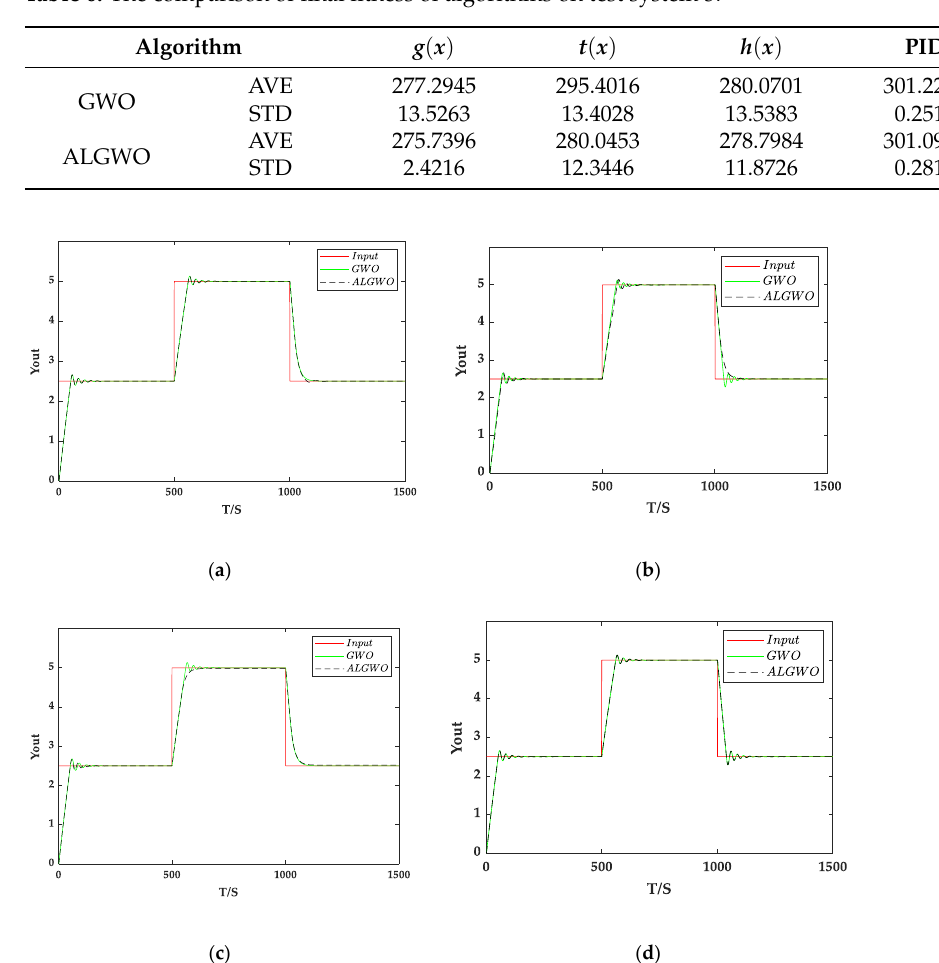
Figure 9. The results of control effect. ( a ) The simulation results of BPNN-PID using g ( x ) and ( b ) simulation results of BPNN-PID using t ( x ) and ( c ) simulation results of BPNN-PID using h ( x ) and ( d ) simulation results of conventional PID.